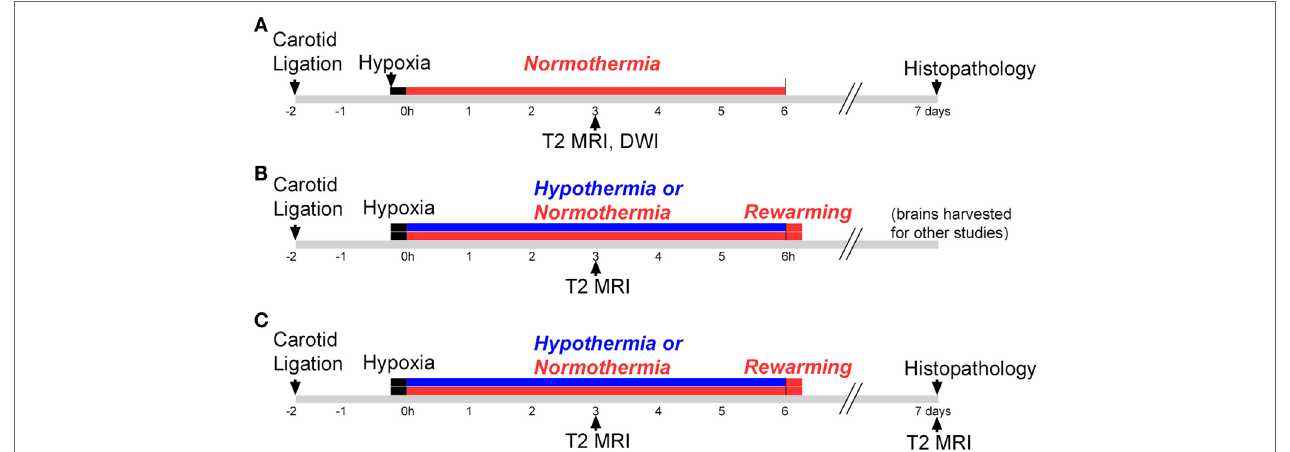
FigUre 1 | Experimental timelines. Experiments were conducted in three phases. (a) Phase 1: mice were subjected to hypoxic ischemia (HI) on postnatal day 7 (P7), followed by a 6 h period of normothermia. T2-weighted magnetic resonance imaging (MRI) and diffusion-weighted MRI (DWI) were carried out 3 h after HI. Brain injury was scored in T2 MRI using a qualitative scale. Mice were euthanized and histopathology was examined 7 days after HI, on P14. (B) Phase 2: mice were subjected to HI on P7, followed by a 6 h period of hypothermia or normothermia (brains were harvested for other studies not shown here). The validated T2 MRI score was determined at 3 h. (c) Phase 3: mice were subjected to HI on P7, followed by a 6 h period of normothermia or hypothermia. T2-weighted MRI was obtained and scored 3 h and 7 days after HI, and brain injury was examined in histological sections 7 days after HI.